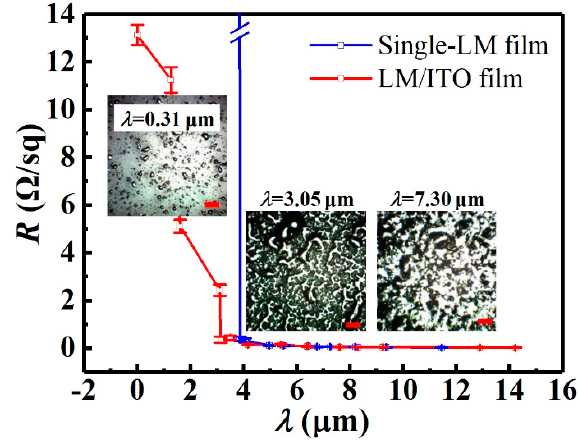
Figure 3. Sheet resistance ( R ) of the single-LM and LM/ITO films at different thicknesses ( λ ), with inset microscopic images of LM surfaces with λ of 0.31, 3.05, and 7.30 µ m. Scale bars are 20 µ m.